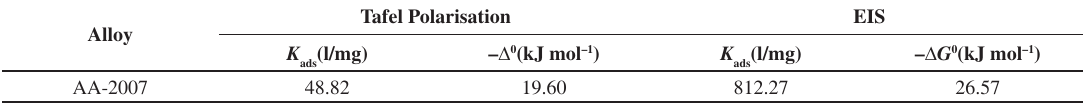
Table 6. Thermodynamic parameters of Langmuir plots obtained from TP and EIS. Alloy